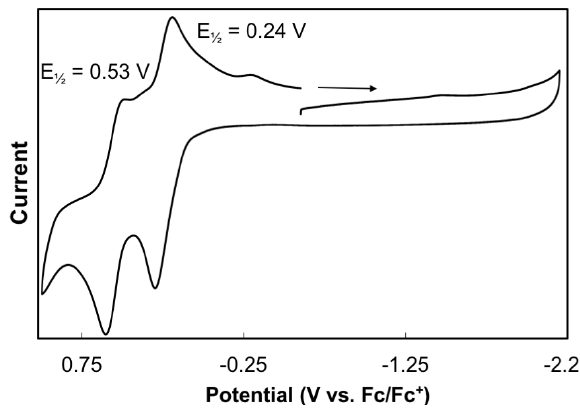
Figure 5. Cyclic voltammogram of 1 recorded in 0.1 M [ n -Pr 4 N][BAr F ] CH 2 Cl 2 solution.